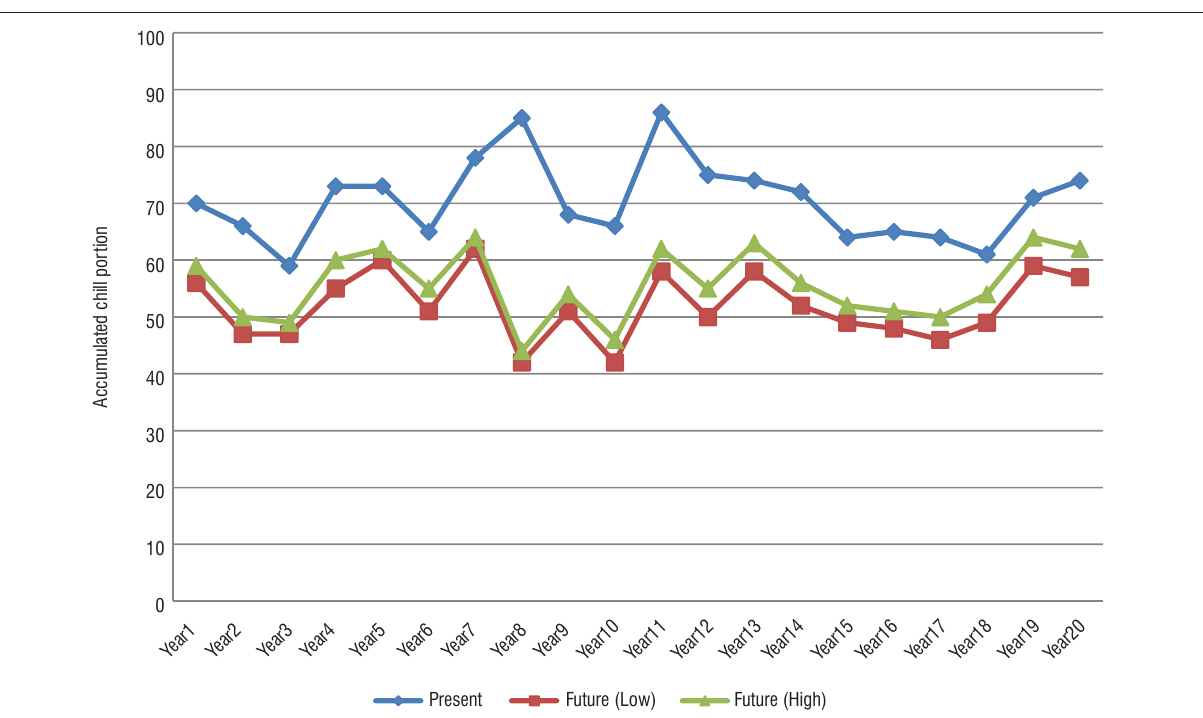
Figure 2: Comparison between the accumulated chill in the present and future climate using the dynamic chill portion